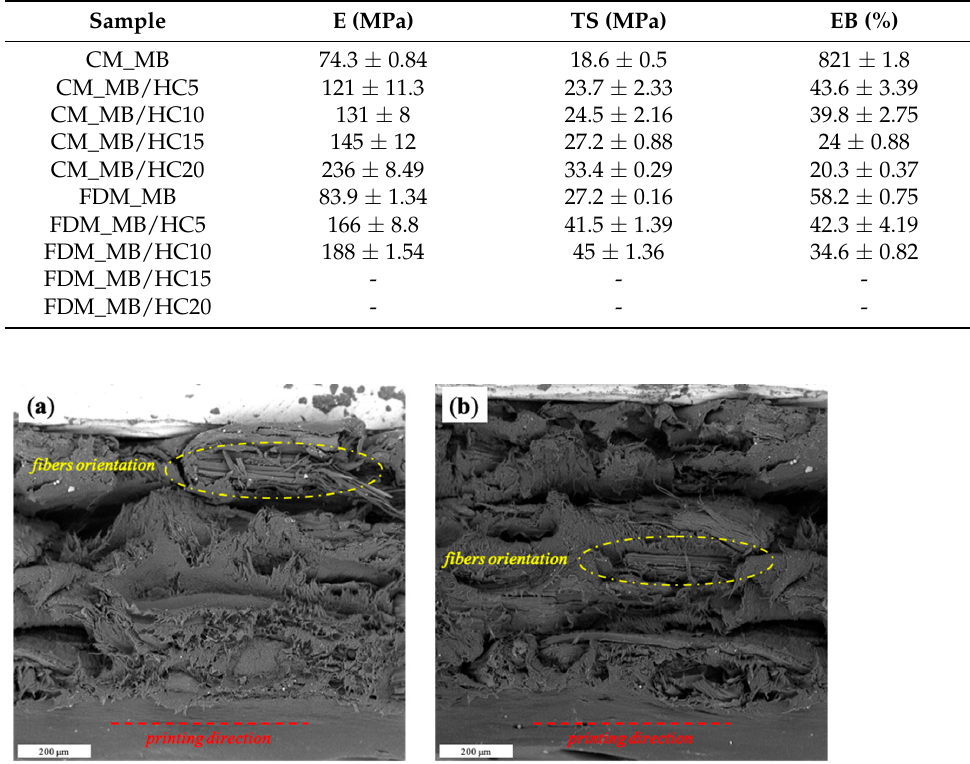
Figure 4. SEM micrograph of fractured cross-sections of CM_MB/HC5 ( a ), CM_MB/HC10 ( b ), CM_MB/HC15 ( c ) and CM_MB/HC20 ( d ). Red circles highlight poor filler wettability parts. Table 3. Elastic modulus (E), tensile strength (TS) and elongation at break (EB) of sample obtained by compression molding and FDM.